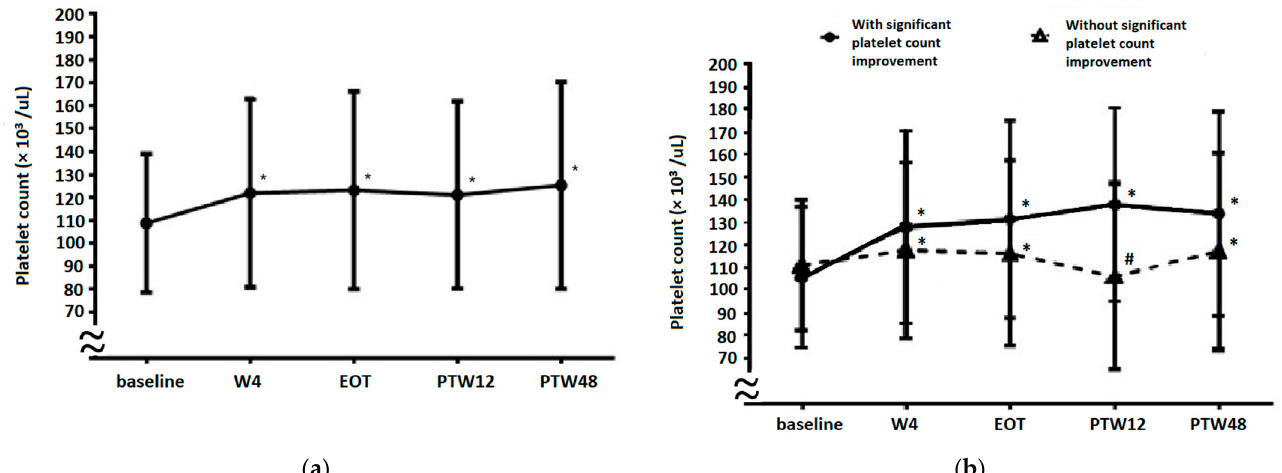
Figure 2. The dynamic changes in platelet counts from baseline to W4, EOT, PTW12, and PTW48 in ( a ) the overall cohort and ( b ) patients with and without significant platelet count improvement. * Platelet counts are significantly increased when compared with baseline levels. # Platelet counts are significantly decreased compared with baseline levels ( p < 0.001 for W4 vs. baseline, EOT vs. baseline, PTW12 vs. baseline, and PTW48 vs. baseline). W4, week 4; EOT, end-of-treatment; PTW12, 12 weeks post-treatment follow-up; PTW48, 48 weeks post-treatment